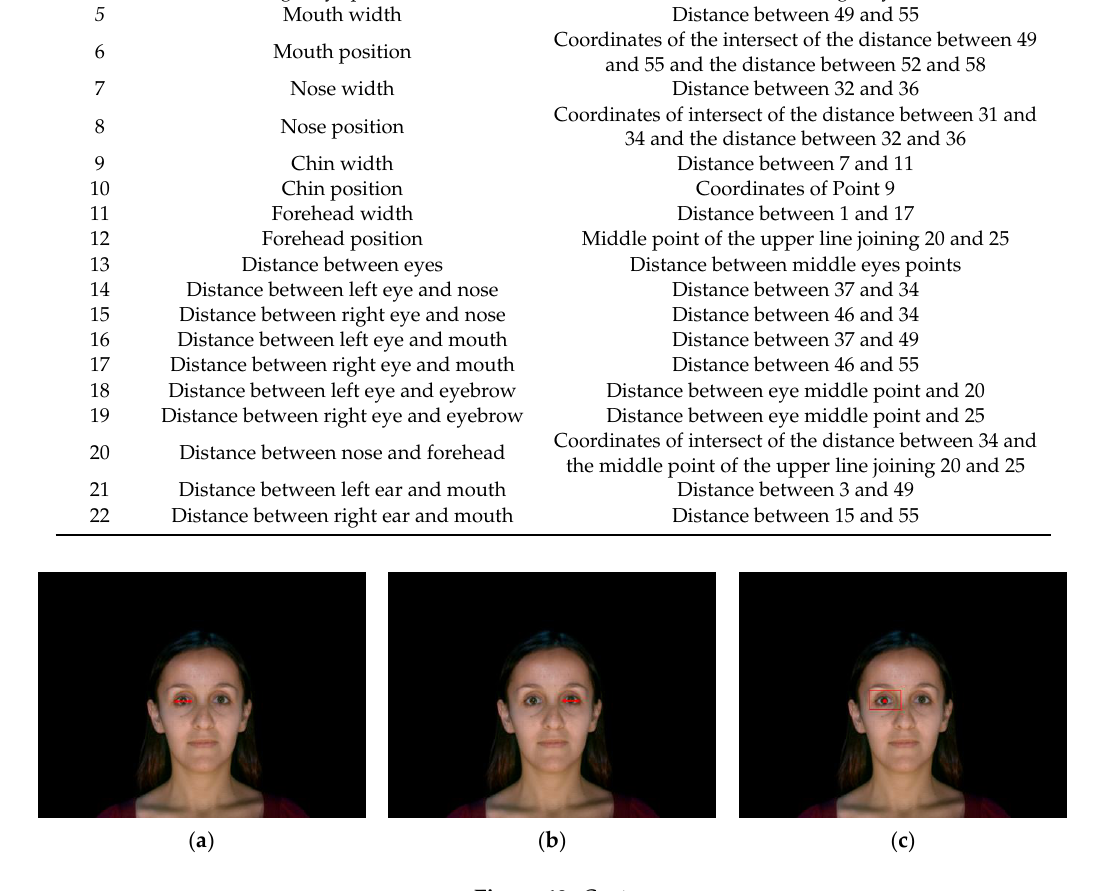
Table 2. Facial features and the corresponding points in 68 landmarks template.